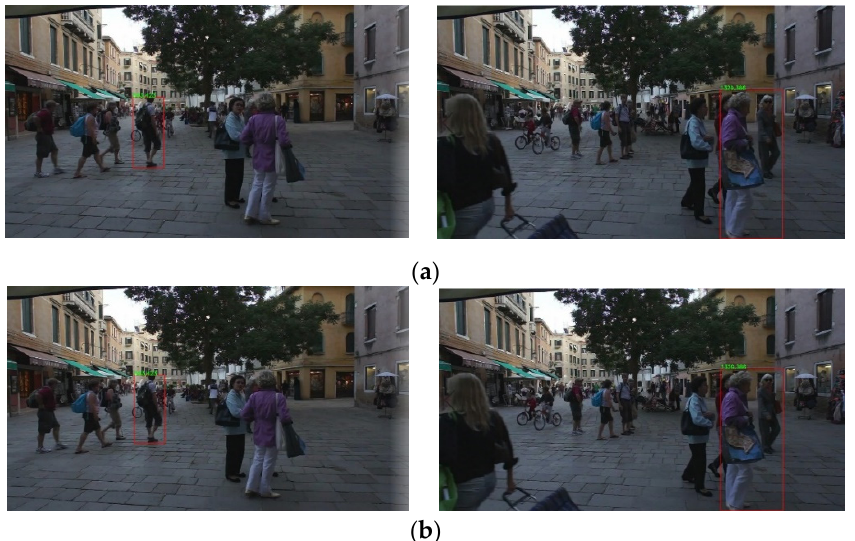
Figure 7. Tracking results of two identical image sequences. MOT16 [15] dataset was used to verify the basic function of tracking system: ( a ) The tracking results of channel #1; ( b ) the tracking results of channel